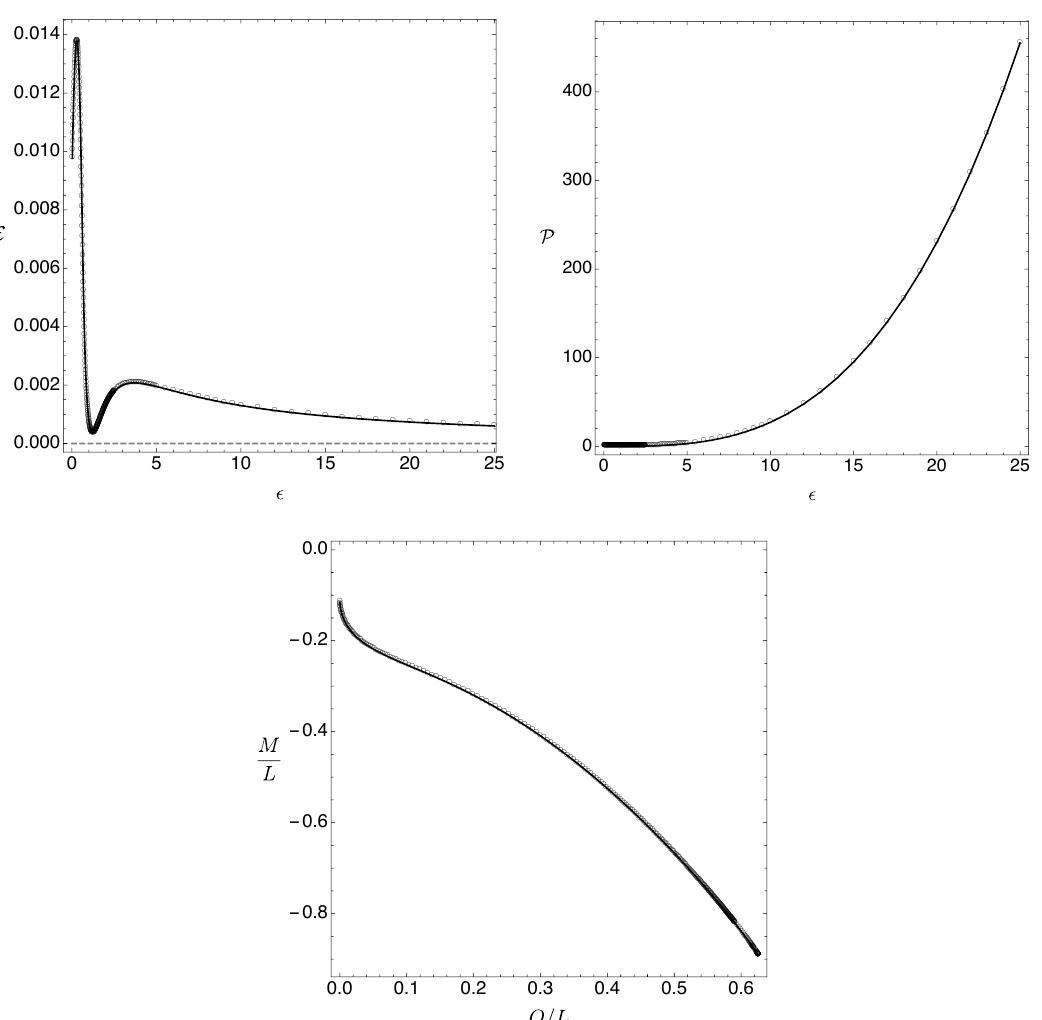
Figure 15 . Properties of a box for a choice of reparametrization normalization N such that the Israel stress tensor satisfies the energy conditions (system with e = 2 . 3 ). Top panel: energy density E and pressure P . Bottom panel: ADM mass M vs ADM charge Q of the soliton solution (measured at the asymptotic region) includes the contribution from the scalar condensate confined inside the box, the energy-momentum content of the box layer and the exterior RN